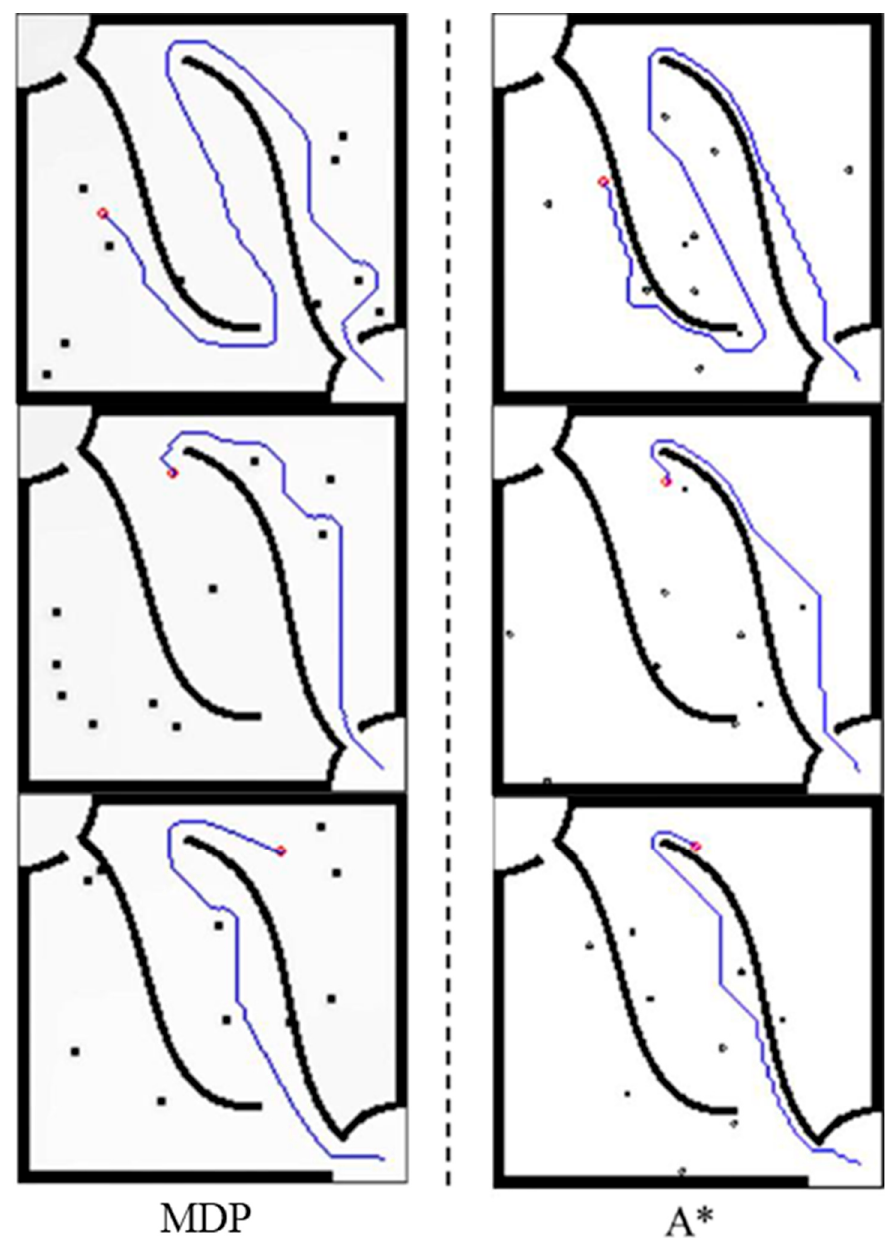
Figure 7. Comparison of MDP and A* path planning in the case of 10 obstacles. Another advantage in this study is that it inherits the advantage of MDP. Tables 2–5 show the time used in the map of 150 × 150 pixels, 5, 10 and 50 mobile obstacles, respectively. Among them, the time required by the MDP method is the secondly generated path, including the cost form value iteration and path finding. When the MDP is generating the first path (since the value function has always been iterated to the starting point position), it will only find the path according to the value function of the entire map, so the time will cost more. At this point, the time is about 11